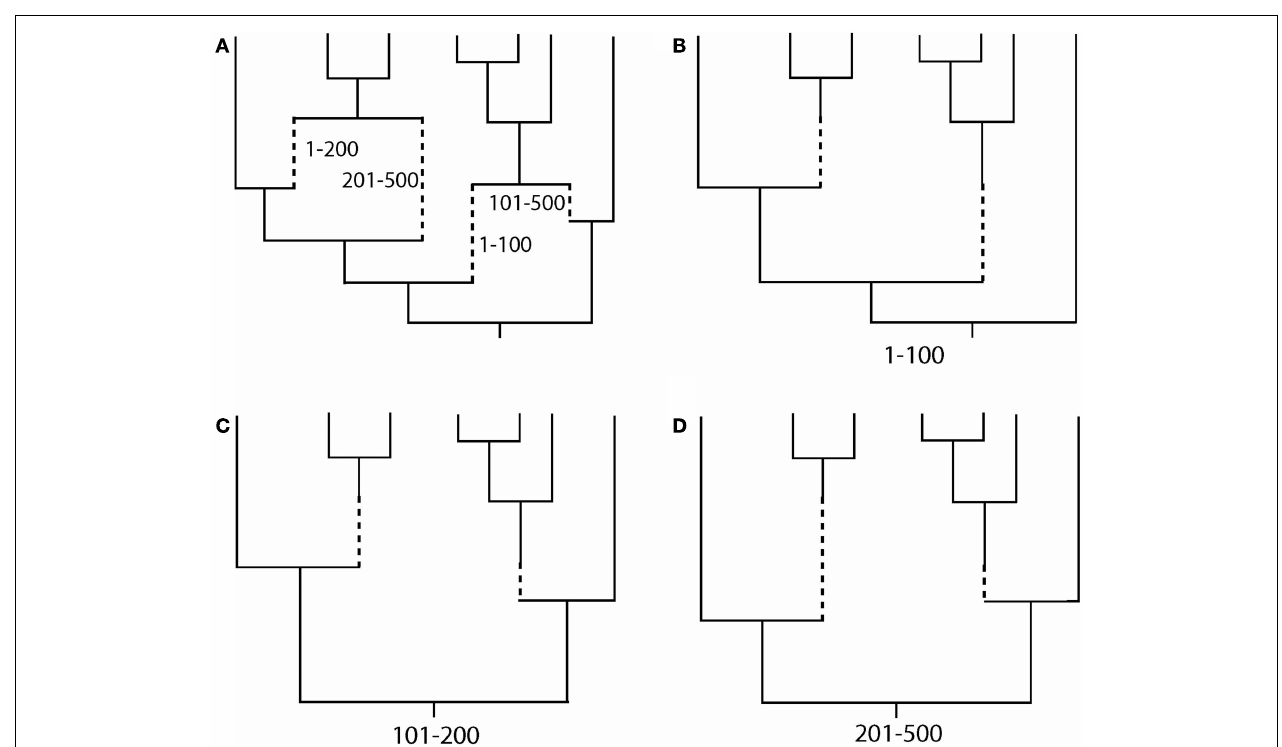
Embedded tree for each recombinant fragment. Note that topologies and branch lengths may differ across trees. Finally, the simulation of sequence evolution can be performed site by site along the corresponding tree (see, Yang, 2006; Fletcher andYang,